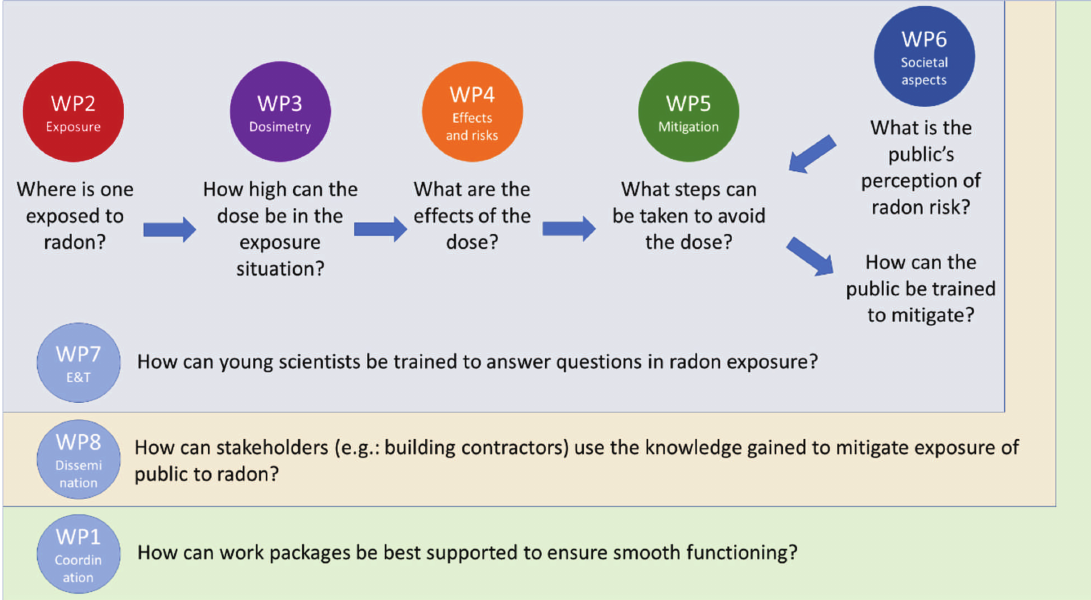
Fig. 3. How work packages contribute to the scientific process using radon as a case